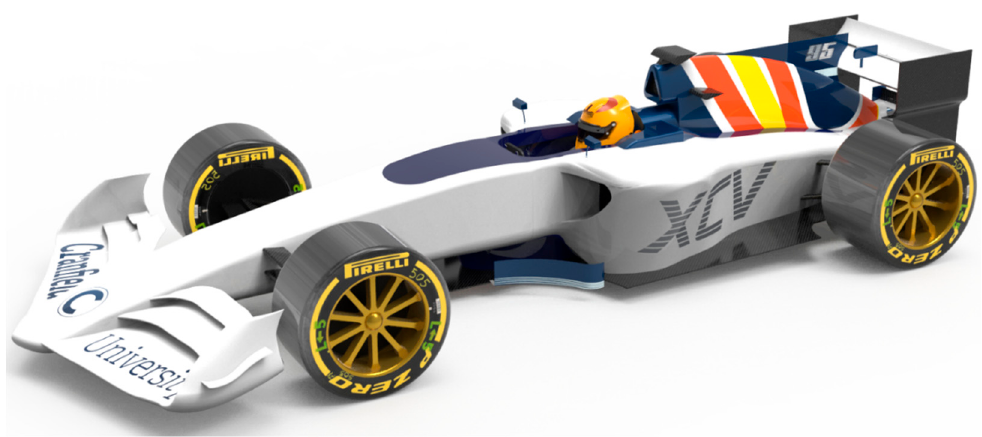
Figure 2. 2022 front wing attached to a 2018 Formula One car (the whole design is performed and developed by the authors).